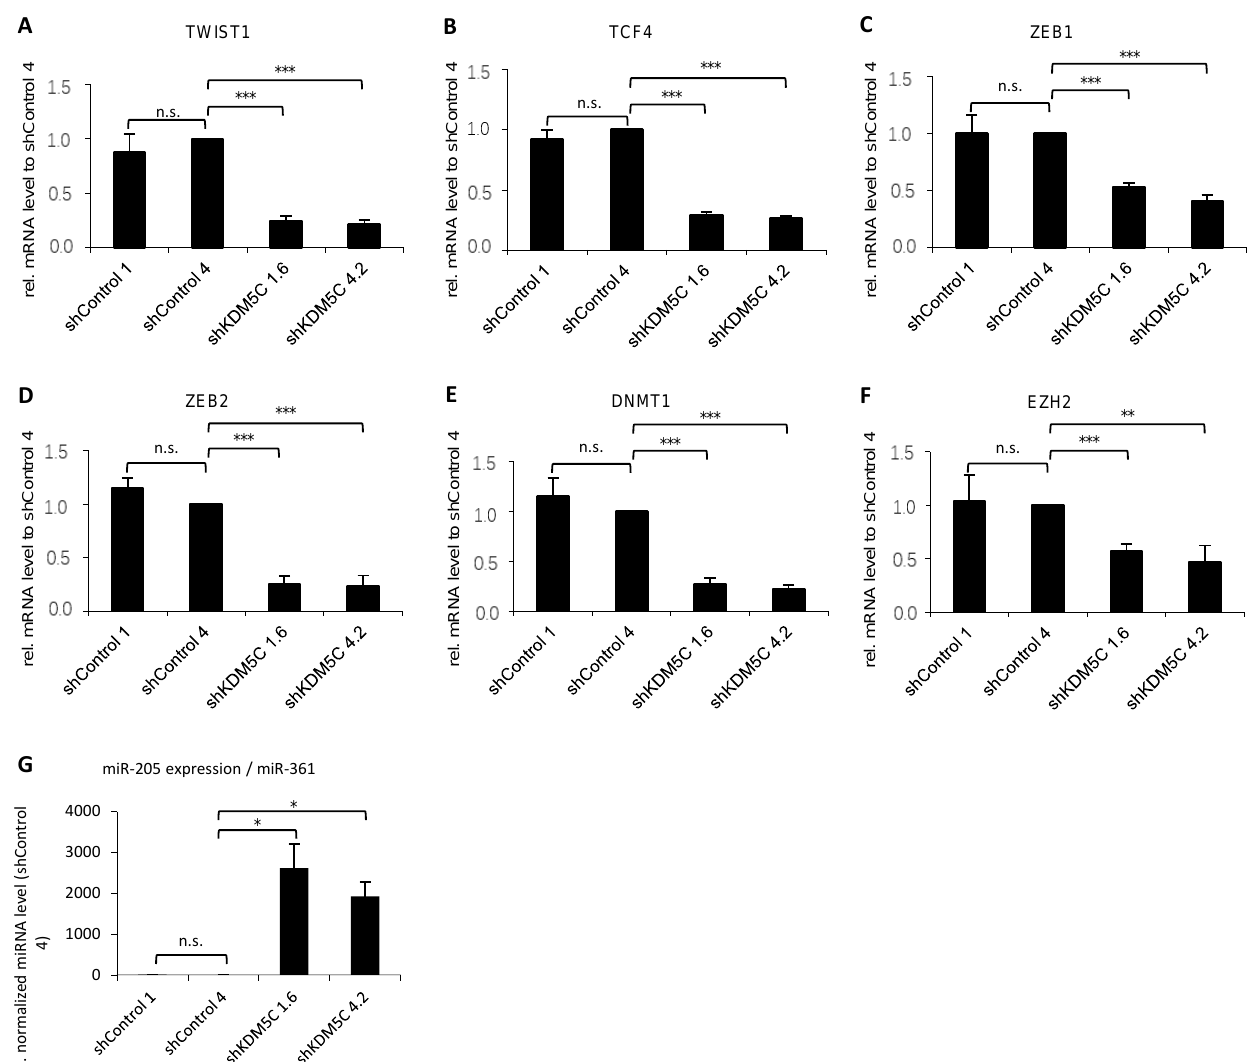
Figure 4. Expression of transcription factors (( A ) TWIST1 ; ( B ) TCF4; ( C ) ZEB1 ; ( D ) ZEB2 ); epigenetic regulators ( E ) DNMT1; and ( F ) EZH2 ); and miR-205 ( G ), in stable KDM5C knockdown clones. qRT- PCR analysis of mRNA expression ( A – G ) in GFP control as well as KDM5C knockdown clones. mRNA expression ( A – F ) and microRNA expression ( G ) were normalized to the nuclear housekeeper TBP and to miR-361, respectively, and in relation to the shControl 4 clone. Error bars represent standard error of the mean from three independent experiments. (n.s. = not significant; * = p < 0.05; ** = p < 0.01; *** = p < 0.001).